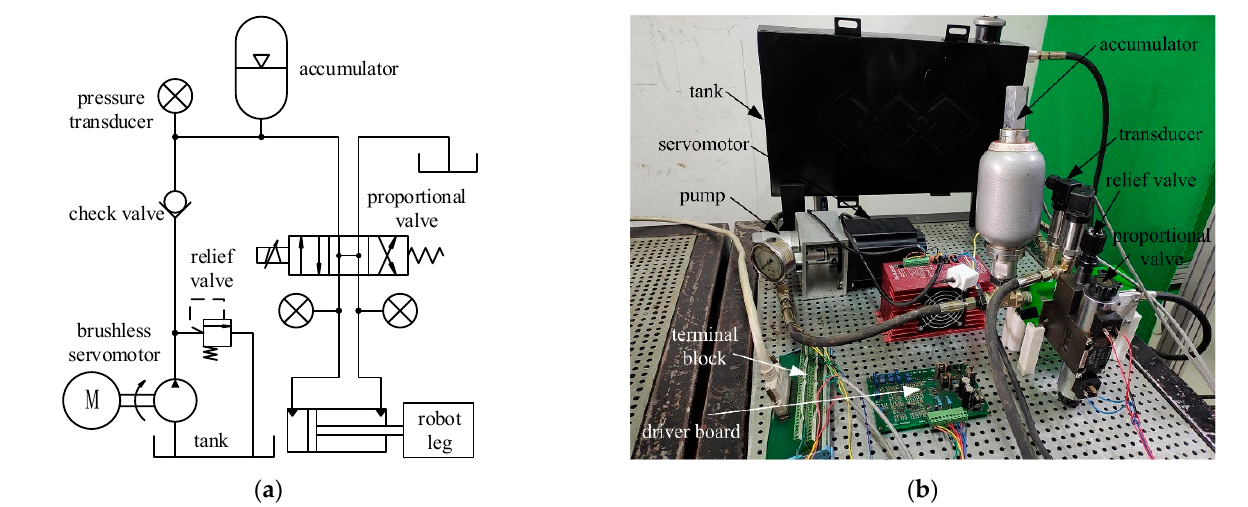
Figure 5. Hydraulic and test system. ( a ) Sketch of the hydraulic system; ( b ) Physical layout of the hydraulic and test system.